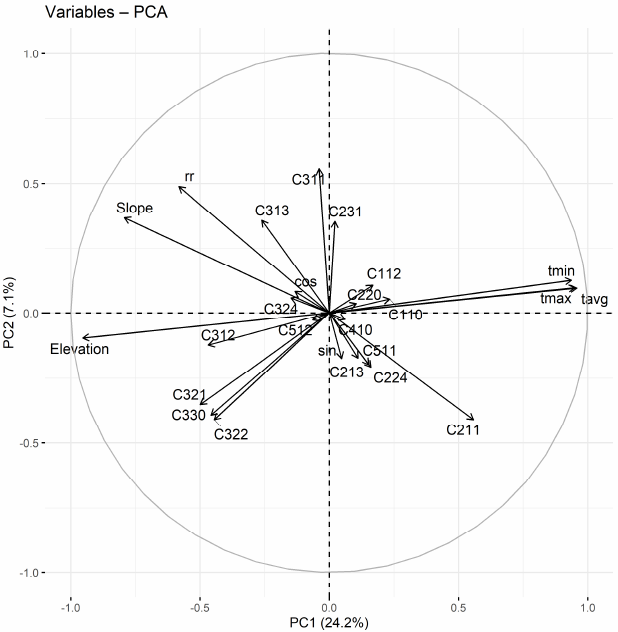
Figure 2. First two axes of the principal component analysis (PCA) that define the E-space, based on 25 input variables. See Section 2.2 for variables’ abbreviations and Tables S3 for variables’ coordi-